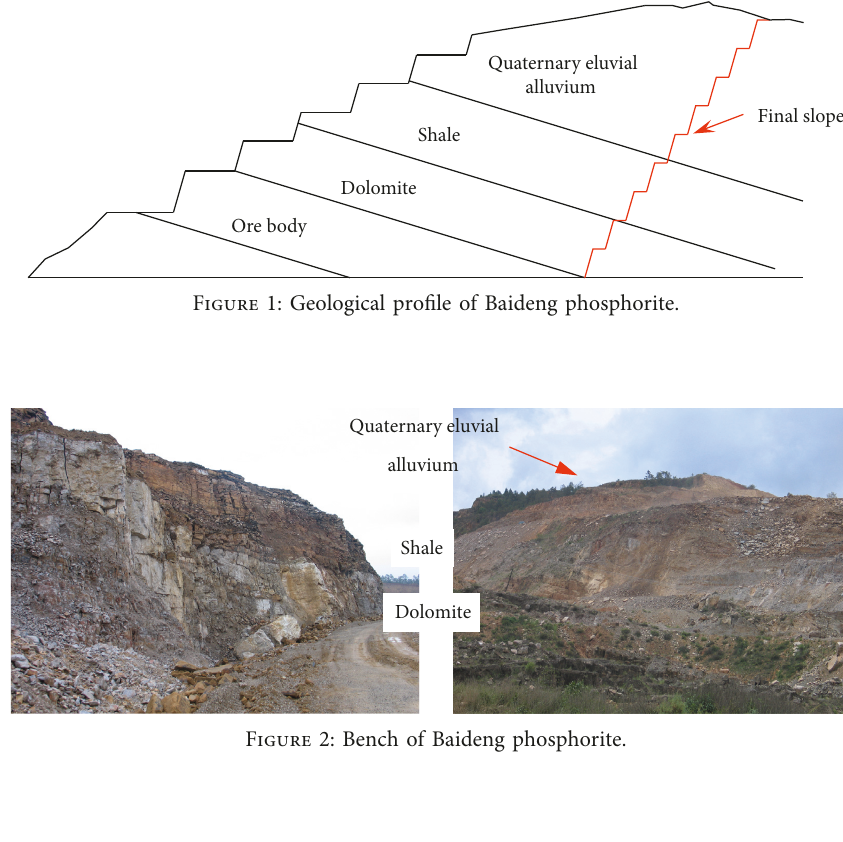
Table 1: Mechanical parameters of rock masses.